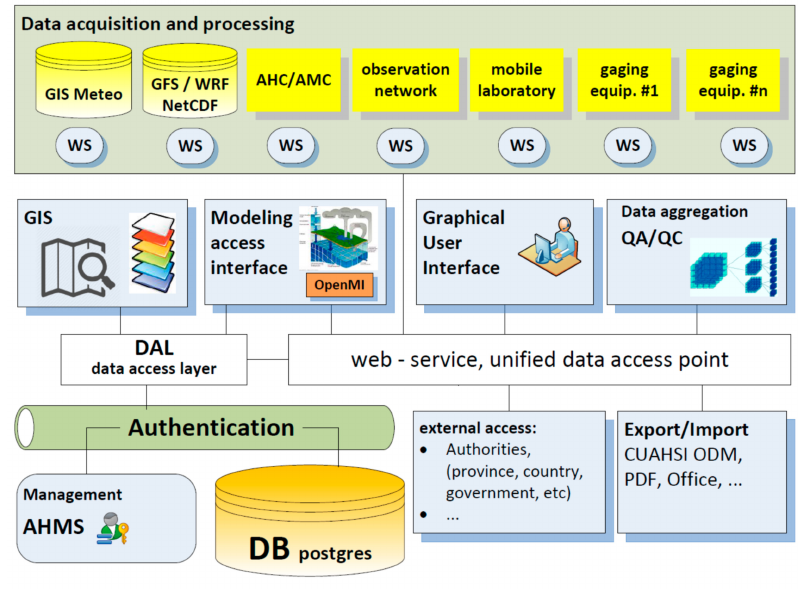
Figure 2. Flow-chart of local AHMS server (AHC/AMC—automatic hydrological/meteorological complex, WS—windows service; DAL—data access library, QA/QC—quality assurance/quality